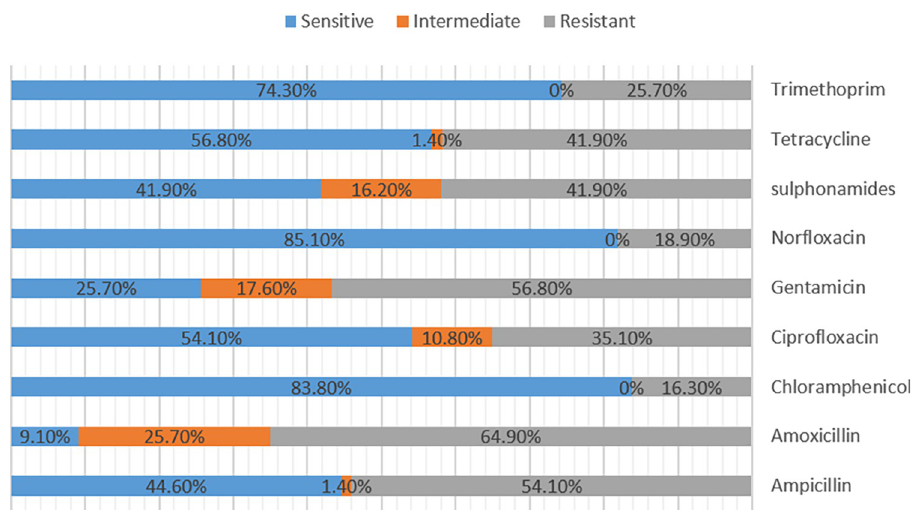
Fig 2. Bar diagram showing antibiotic sensitivity pattern of E . coli